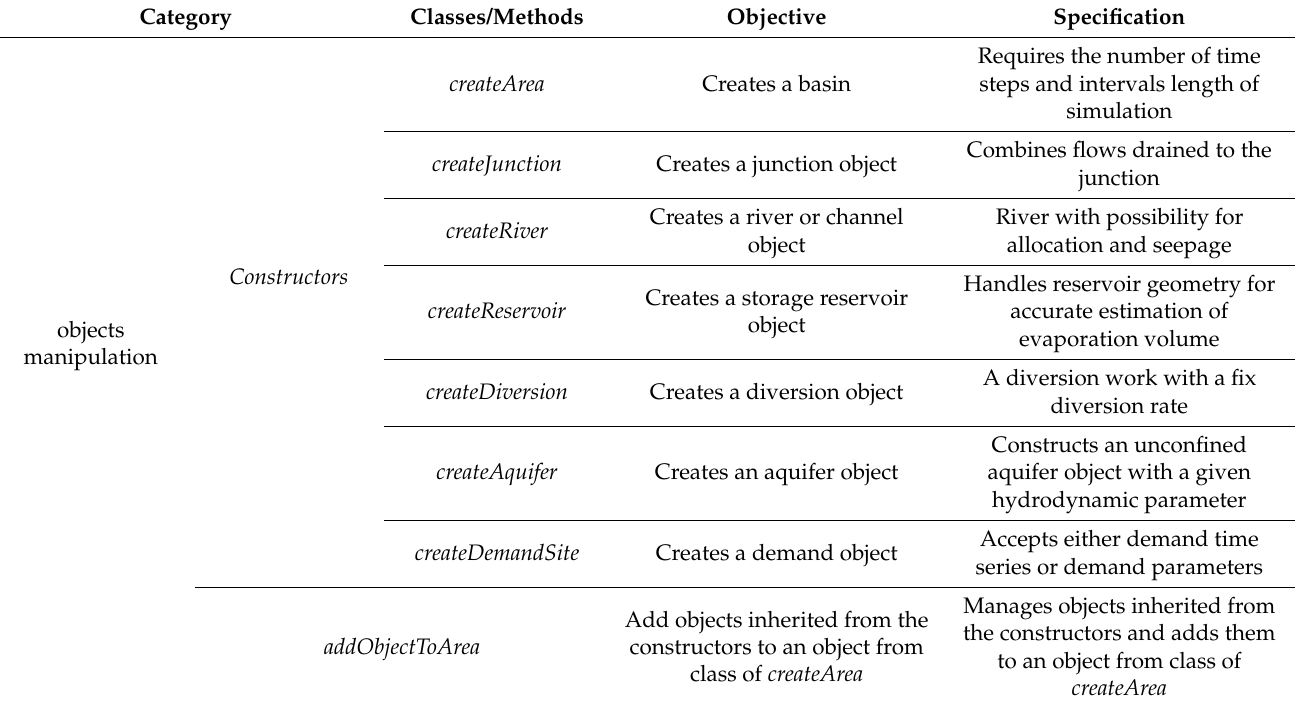
Figure 3. Representation of classes and methods built-in WRSS package through Unified Modelling Language (UML). Table 2. WRSS package